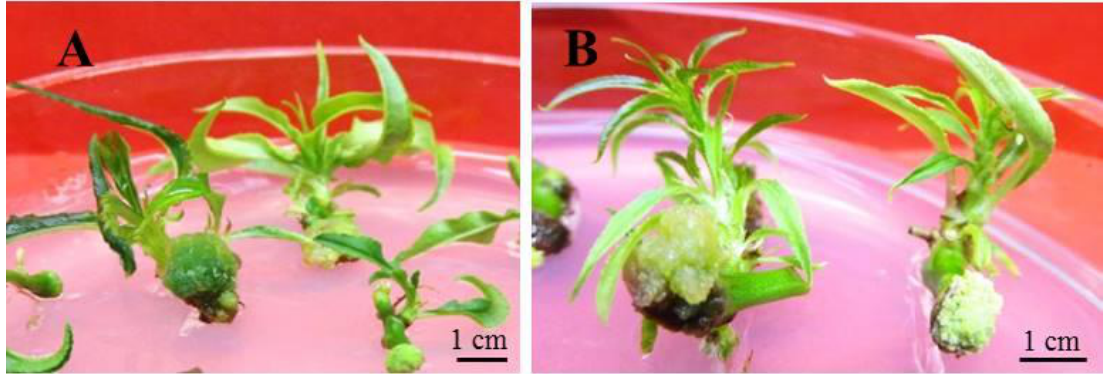
Figure 3. Callus formation at the base of explants in peach hybrids: ( A ) ‘Loadel’ × ‘Nikitskiy Podarok’ on MS medium with